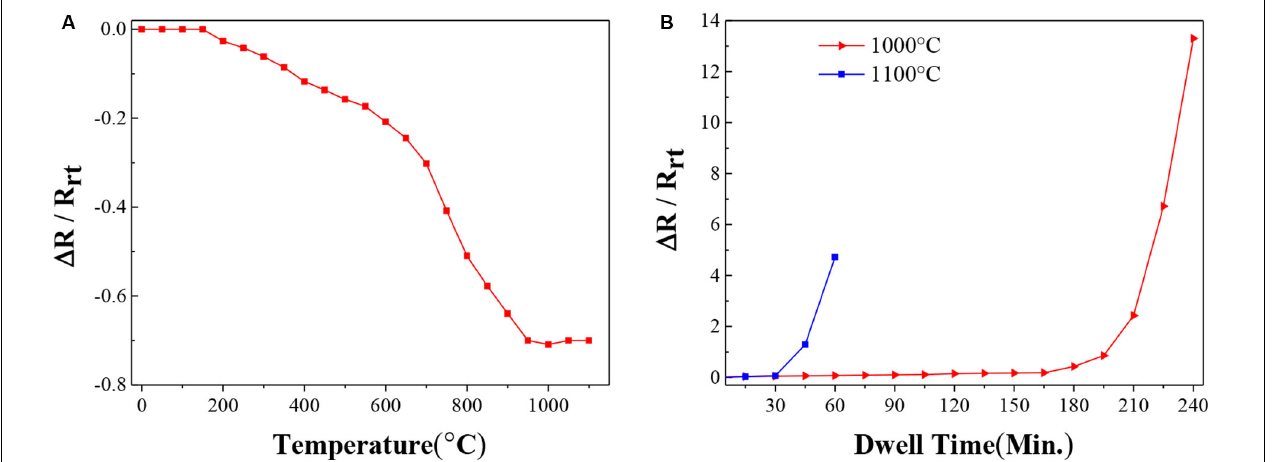
FIGURE 2 | Real-time resistance changes of the ITO films deposited onto LGS substrates as the function of (A) temperature and (B) dwell time at 1,000 and 1,100 ◦ C.